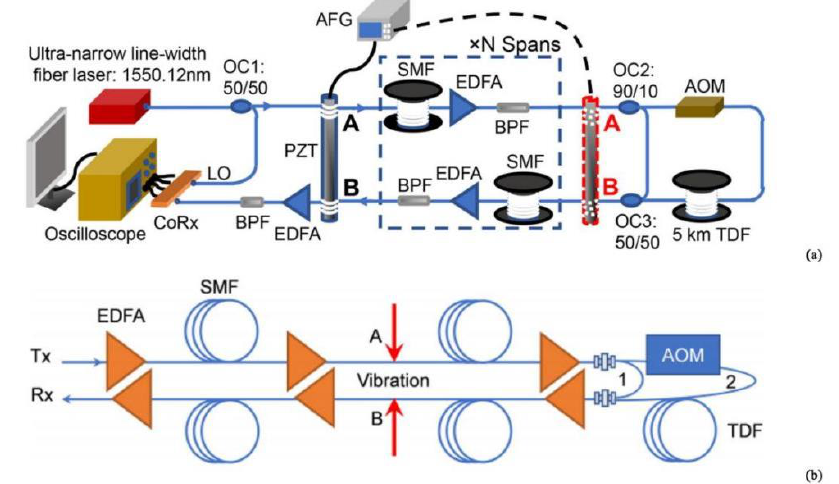
Figure 13. ( a ) Experimental setup. ( b ) Schematic diagram of the localization principle